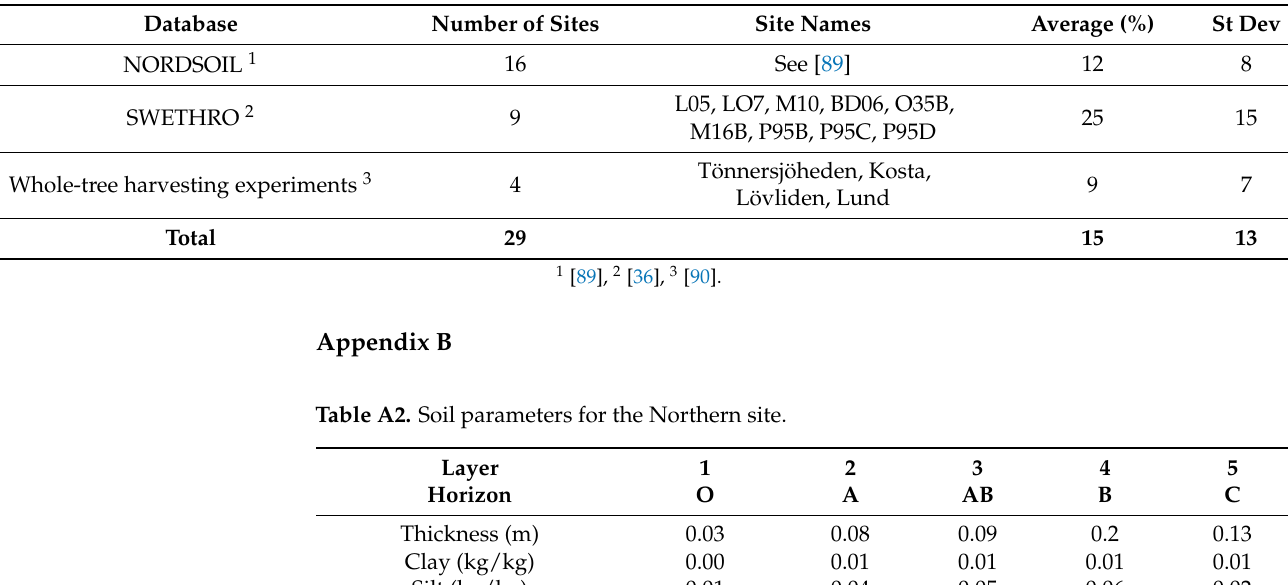
Table A1. Average proportions of clay in the clay + silt fraction in three different databases, and the overall average used in this study.